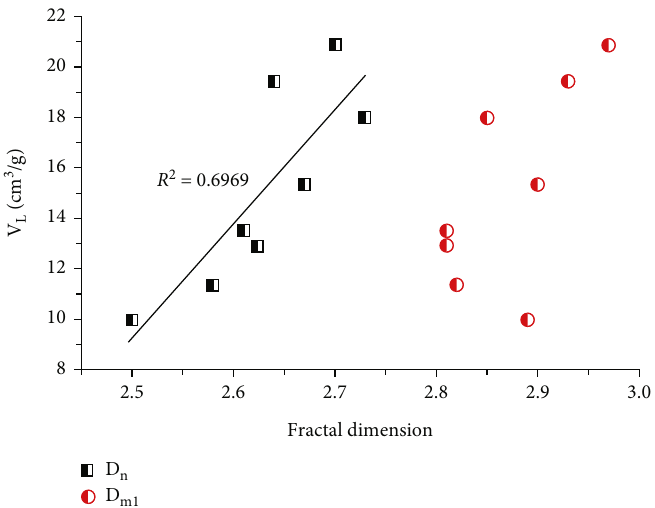
Figure 12: Relationship between the maximum methane adsorption capacity and fractal dimensions.